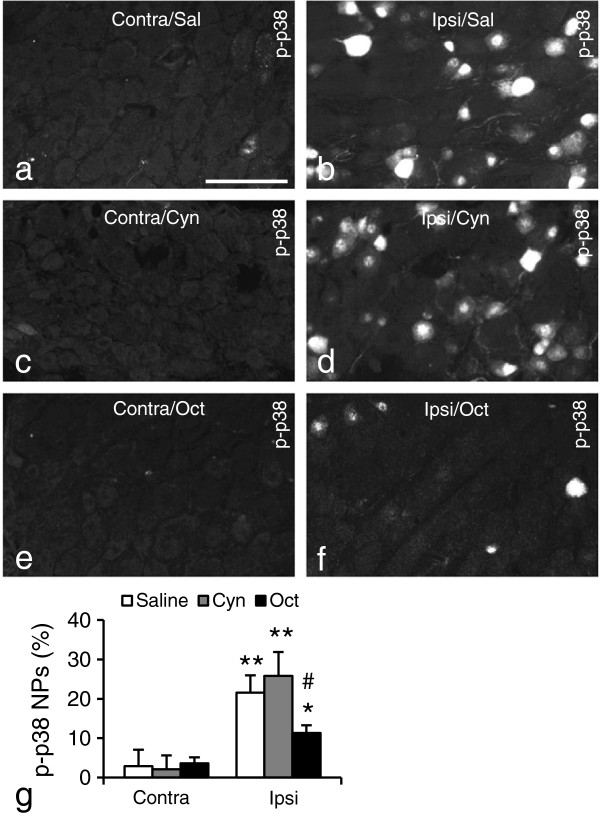
Effect of Oct on p-p38 expression DRGs after SNI. (a-f) Micrographs of contralateral (a, c, e) or ipsilateral DRGs (b, d, f), in saline (Sal; a, b), Cyn154806 (Cyn; c, d) or Oct (e, f) -treated animals 14 days after SNI. (g) Quantitative evaluation of percentage of p-p38+ NPs. Oct, but not Cyn154806 or saline significantly reduces the SNI-induced ipsilateral upregulation of p-p38-LI. *P < 0.05; **P < 0.01 compared with contralateral DRGs; #P < 0.05 compared with saline or Cyn154805 groups in the ipsilateral DRGs, respectively. Scale bar indicates 100 μm (a).